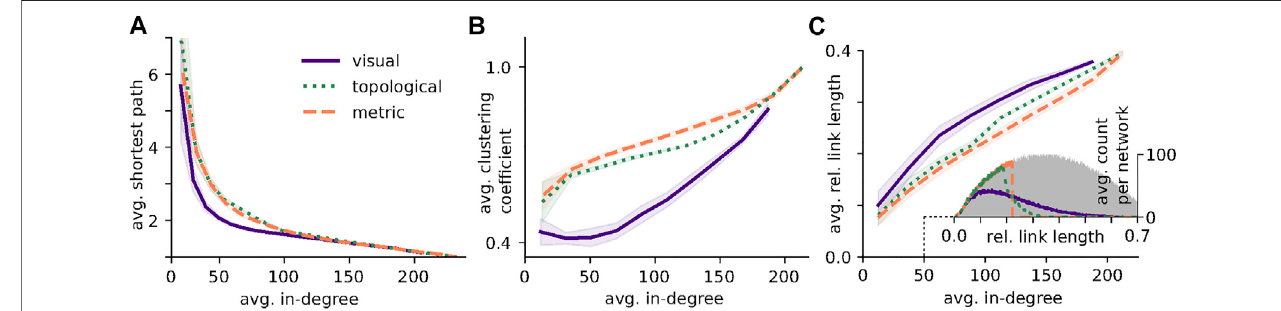
FIGURE3| Degreedependence ofnetworkmeasures . AllFigureswerecreated usingnetworksof N (cid:1) 225averagedoveralldensitiesandthresholds. (A) Average shortest path length as a function of average in-degree. At low in-degrees visual networks exhibit shorter shortest-path lengths than both metric and topological networks. (B) Averageclusteringcoef fi cientasafunctionofaveragein-degree.ConsistentwiththeresultsinFigure2visualnetworkdisplaysubstantiallylowerclustering acrossawiderangeofin-degreesthanbothmetricandtopologicalnetworks. (C) Averagerelativelinklengthasafunctionofaveragein-degree.Forintermediatein- degree, visual networks exhibit considerable longer links than both metric and topological networks. Inset: Example of the average distribution of relative link length for networks of average in-degree 50. The grey shaded area indicates the link length distribution for a fully connected network. Parameters: g (cid:1) 2.0, θ (cid:1) 0.00505, θ (cid:1) 9.2944, θ (cid:1) 50, averaged over 40 vis metric topo